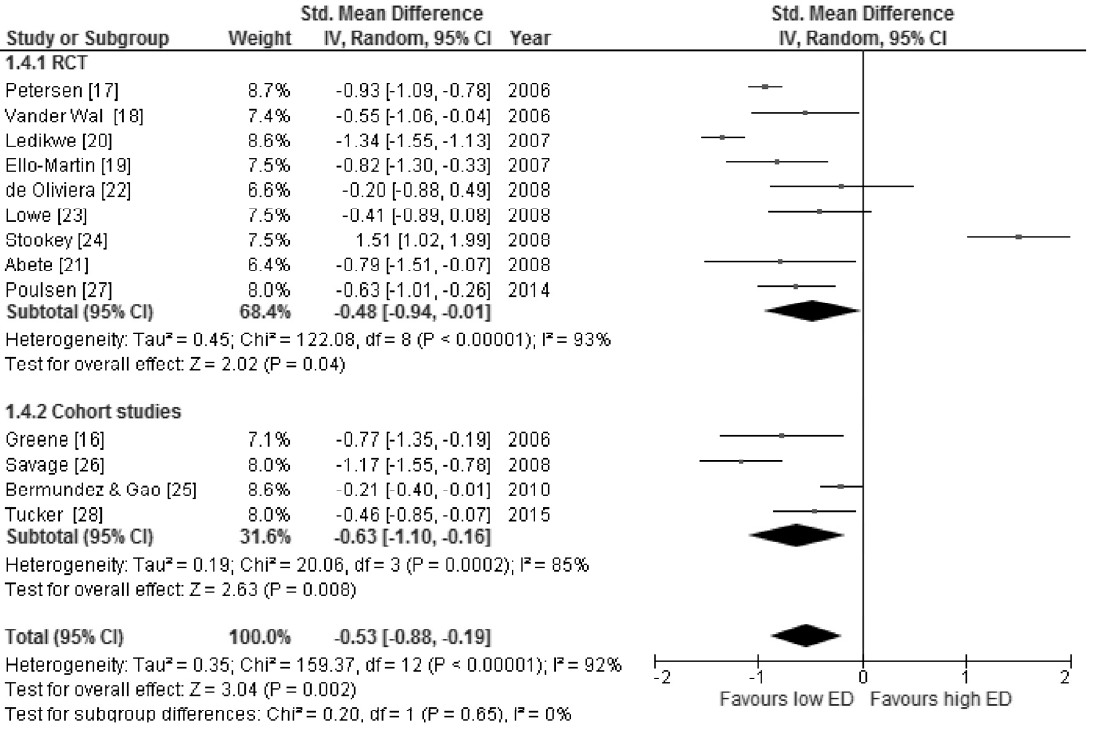
Figure 2. Forest plot of the random-effects meta-analysis of changes in body weight according to food energy density shown as polled standard differences in the means with 95% CIs and in selected cross-sectional studies and randomized trials. For each study, the square represents the point estimate of the intervention effect. Horizontal lines join the lower and upper limits of the 95% CI of this effect. The area of shaded squares reflects the relative weight of the study in the meta-analysis. Diamonds represent the subgroup mean difference and pooled mean differences.